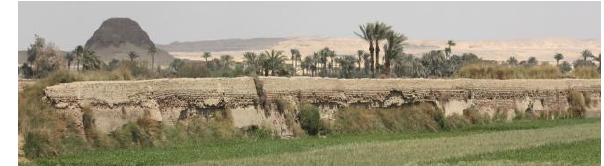
Figure 13. Lahun surrounding landscape, the Lahun pyramid and Gisr Gadallah mud brick barrage,